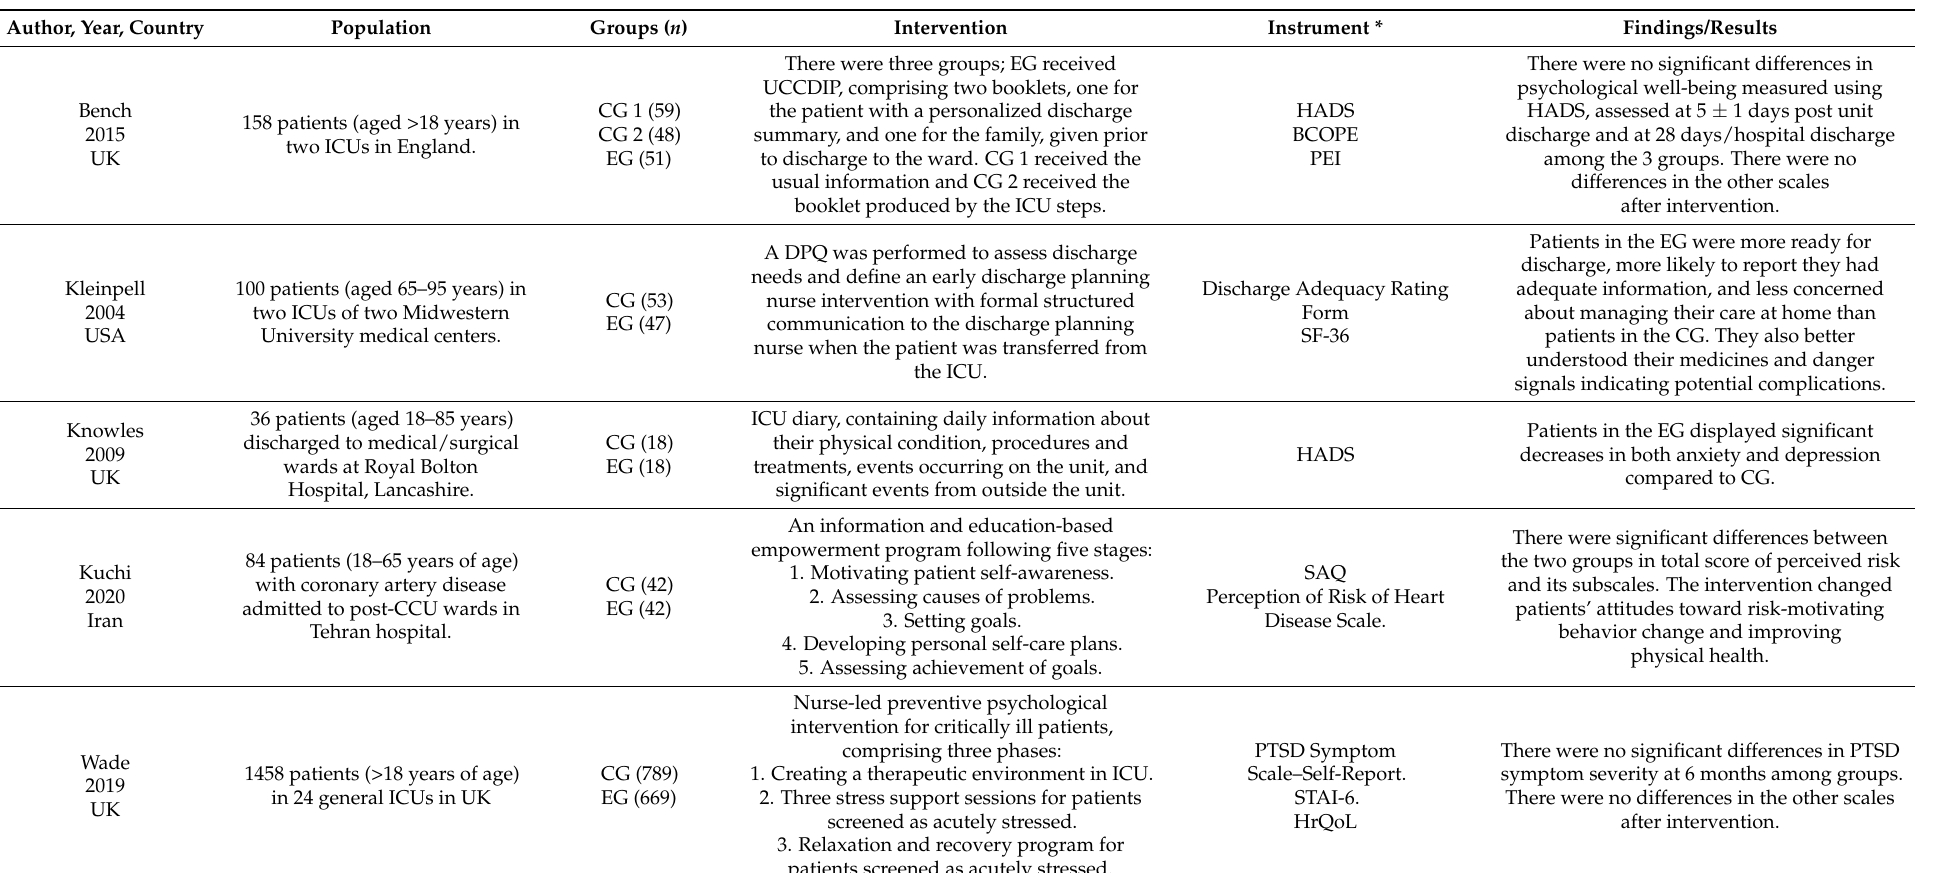
Table 2. Main characteristics of the studies